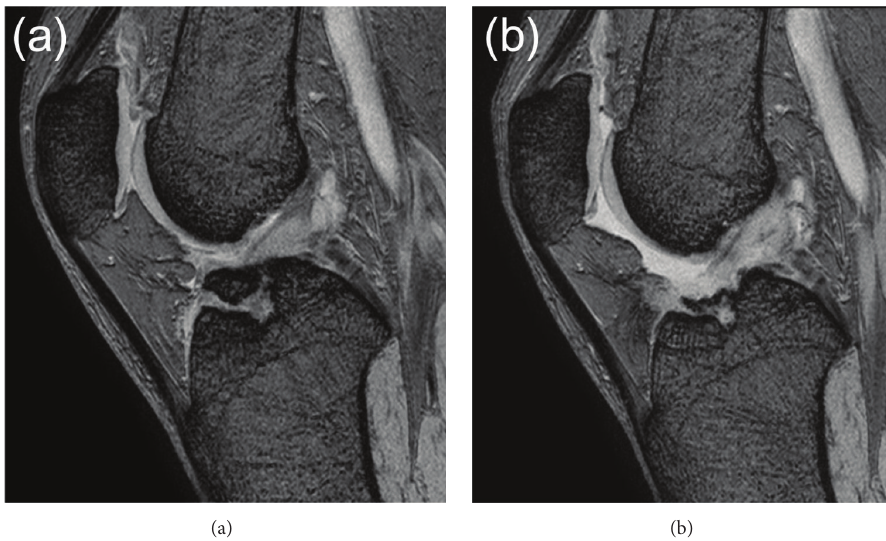
Figure 4: (a) Preoperative magnetic resonance imaging (MRI), showing no rupture in ACL fibers. (b) MRI 6 months after surgery showing only partial rupture of ACL fibers at the site of